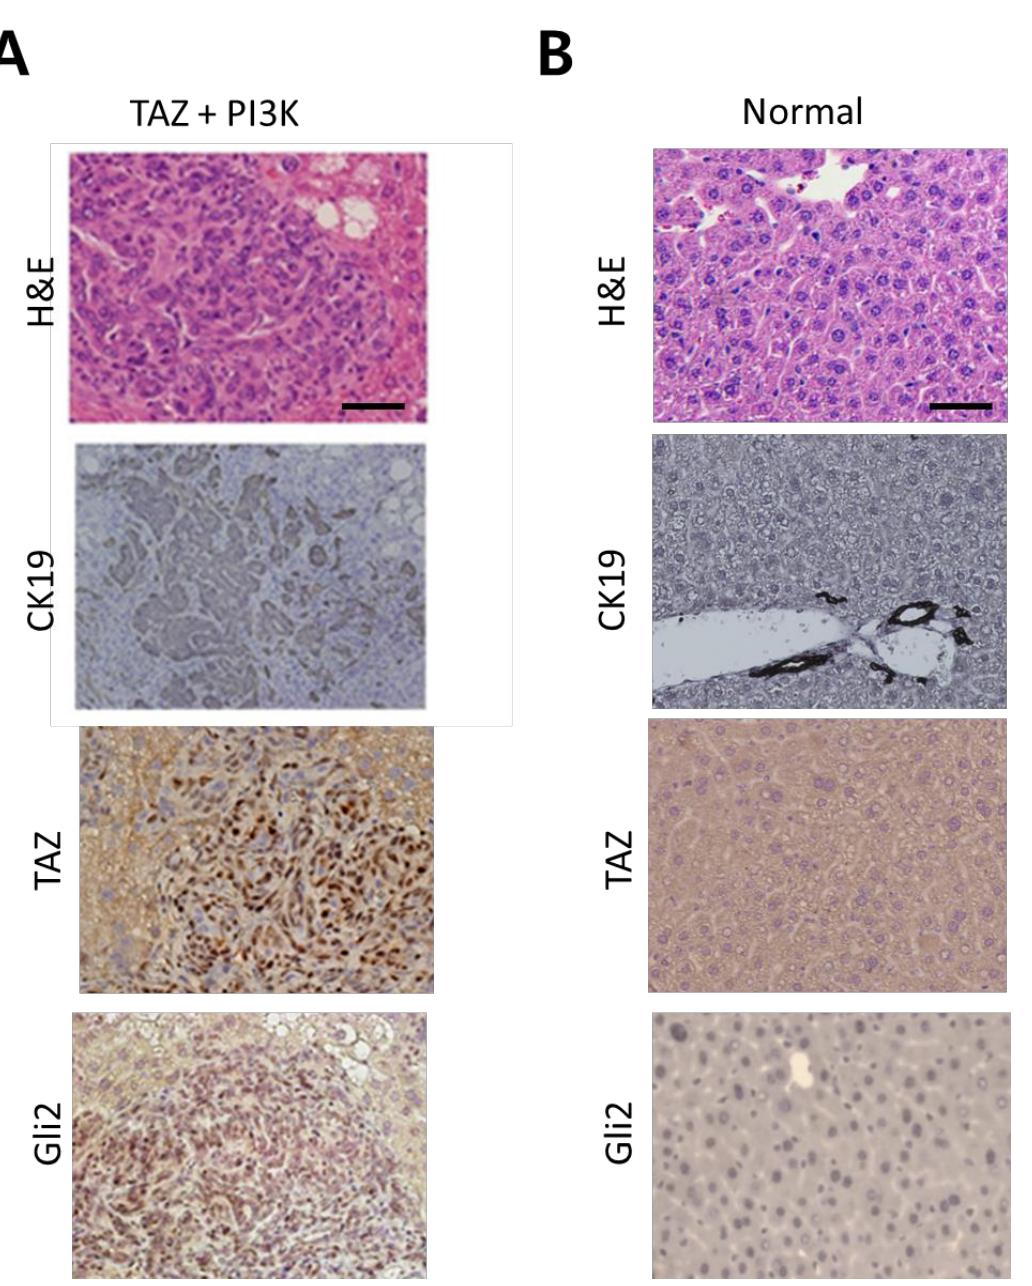
Figure 5. Microscopic analysis of intrahepatic CCC induced by PI3K E545K and TAZ S89A ( A ) H&E and IHC staining of tumor sections from the livers shown in Figure 4B. ( B ) H&E and IHC staining of sections from normal livers. Note that only bile ducts cells in normal livers were stained positive for CK19, while intrahepatic CCC showed ubiquitous expression of CK19. Scale bar, 50 μm.